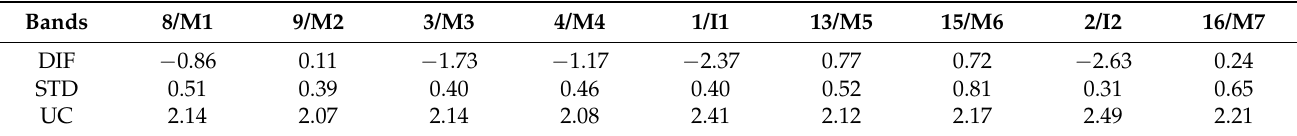
Table 5. Lunar calibration inter-comparison results for Aqua MODIS and N20 VIIRS (WL: wavelength; DIF: difference (Aqua—N20); STD: standard deviation; UC: uncertainty). The values are listed as a percentage and the uncertainties were propagated from the values for each instrument/band listed in Tables 6 and 7.